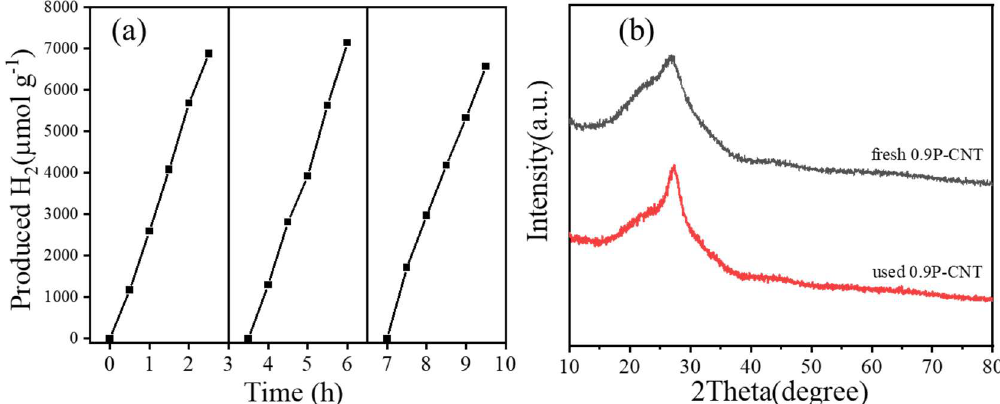
Figure 11. The cyclic hydrogen production test of the 0.9P-CNT sample ( a ) and the XRD patterns of the fresh and used 0.9P-CNT samples ( b ).